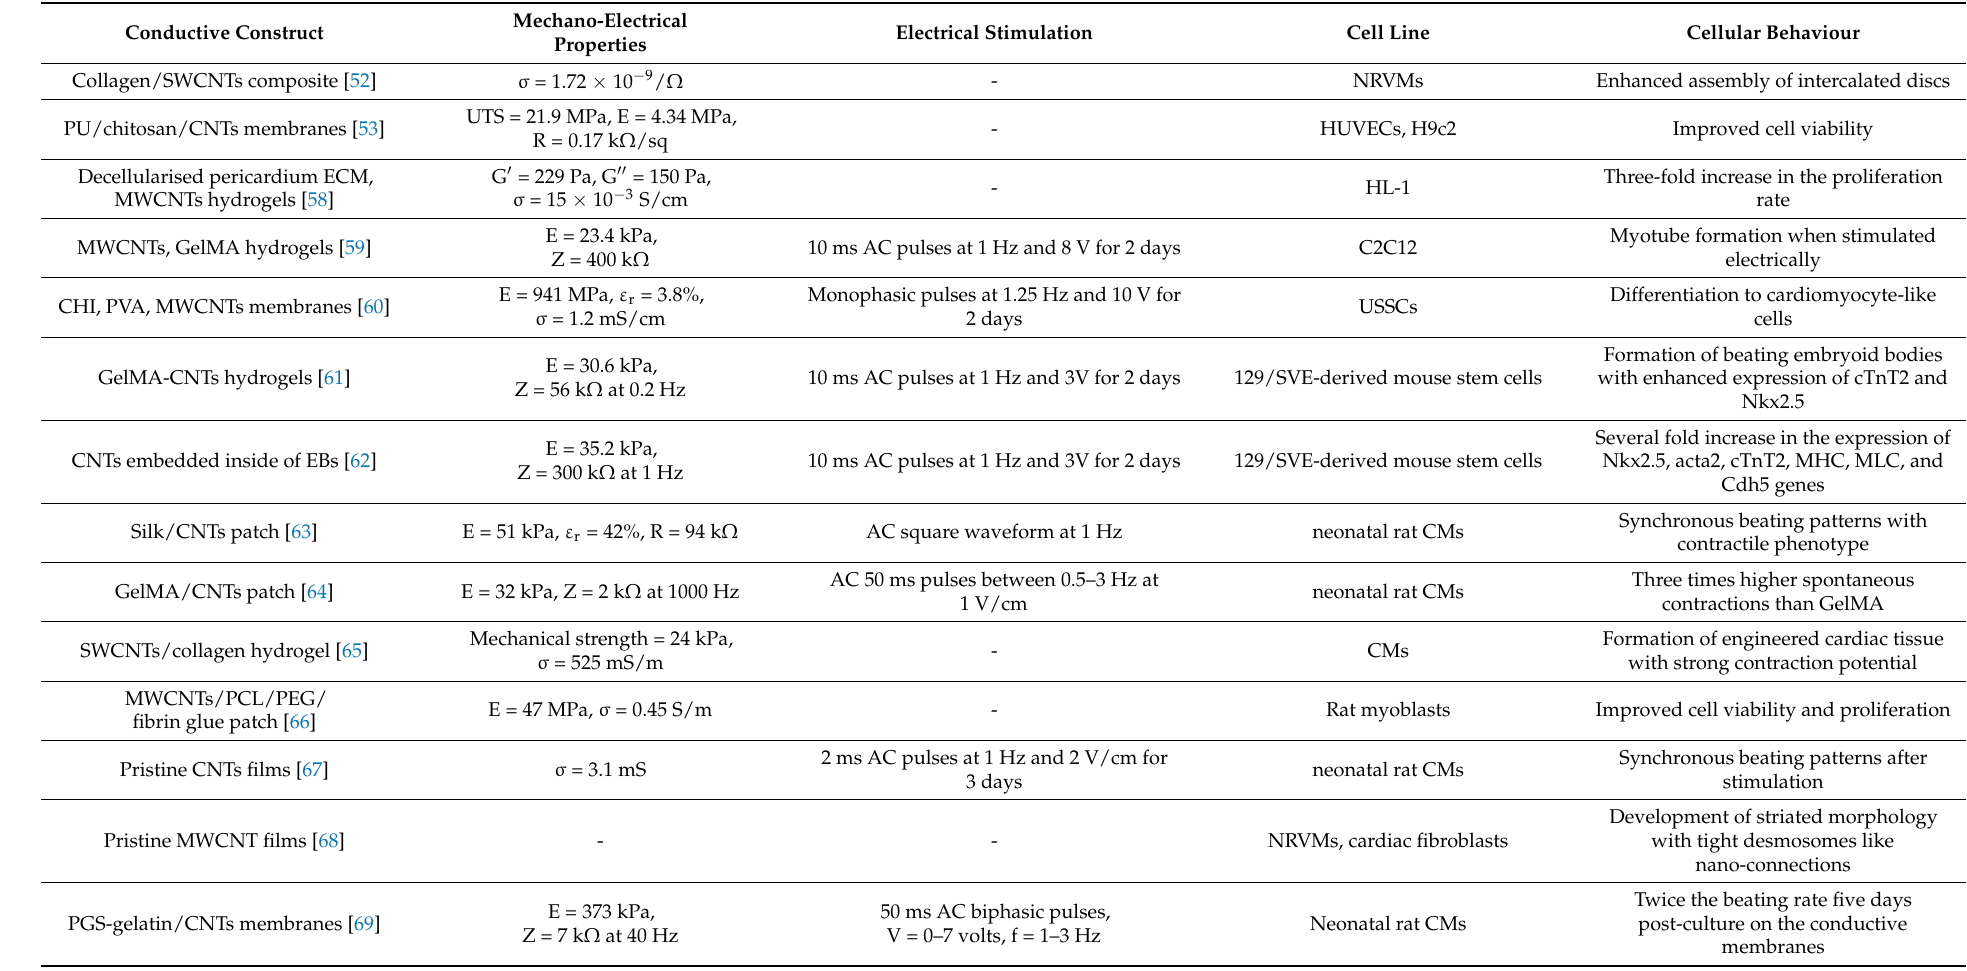
Table 1. Carbon nanotubes-based conductive constructs for cardiac tissue engineering